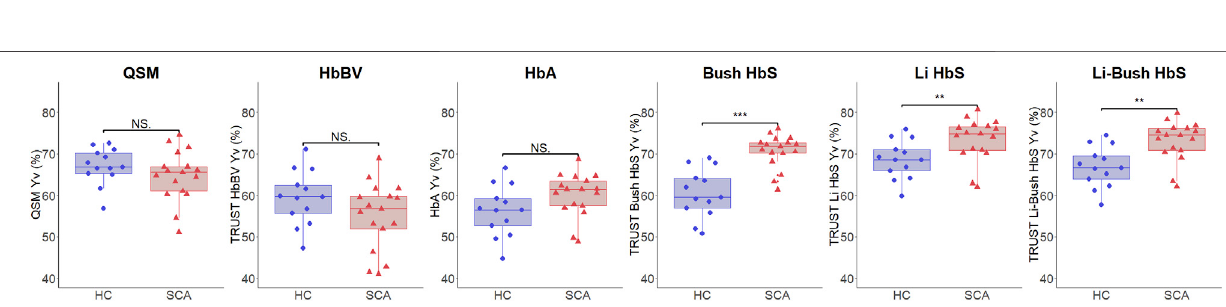
Frontiers in Physiology |